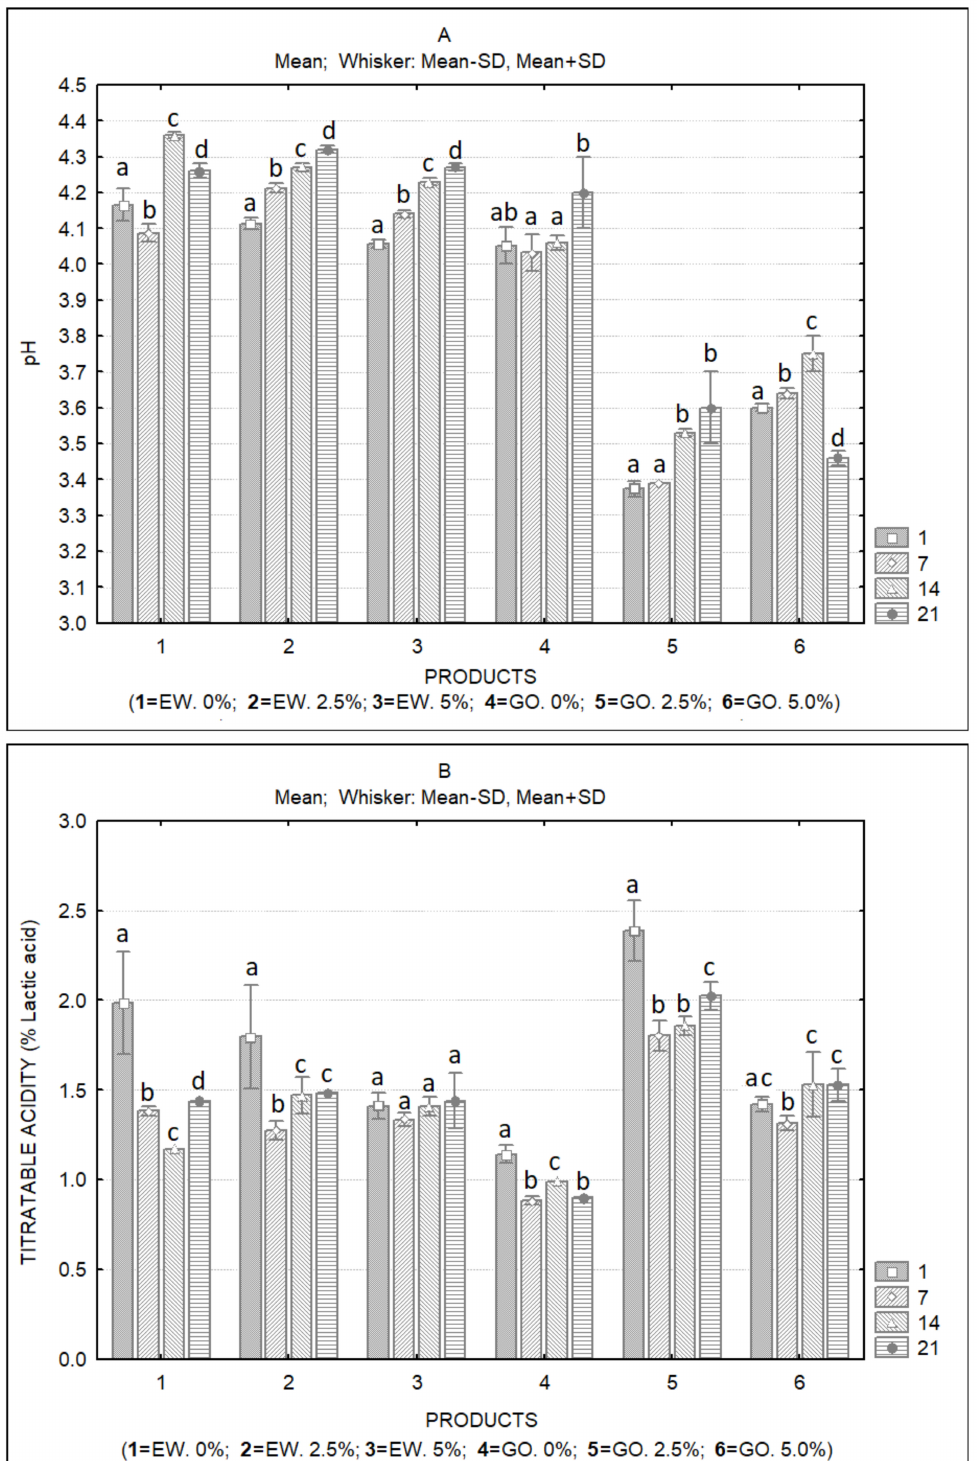
Figure 5. ( A ) pH and ( B ) titratable acidity of ewe’s and goat’s frozen yoghurts produced with UF concentrated cheese whey over 21 days of refrigerated storage (EW. 0% = ewe’s yoghurt with 0% inulin addition; EW. 2.5% = ewe’s yoghurt with 2.5% inulin addition; EW. 5.0% = ewe’s yoghurt with 0% inulin addition; GO. 0% = goat’s yoghurt with 0% inulin addition; GO. 2.5% = goat’s yoghurt with 2.5% inulin addition; GO. 5% = goat’s yoghurt with 5% inulin addition). Different letters indicate significant differences ( p < 0.05) between frozen yoghurts during